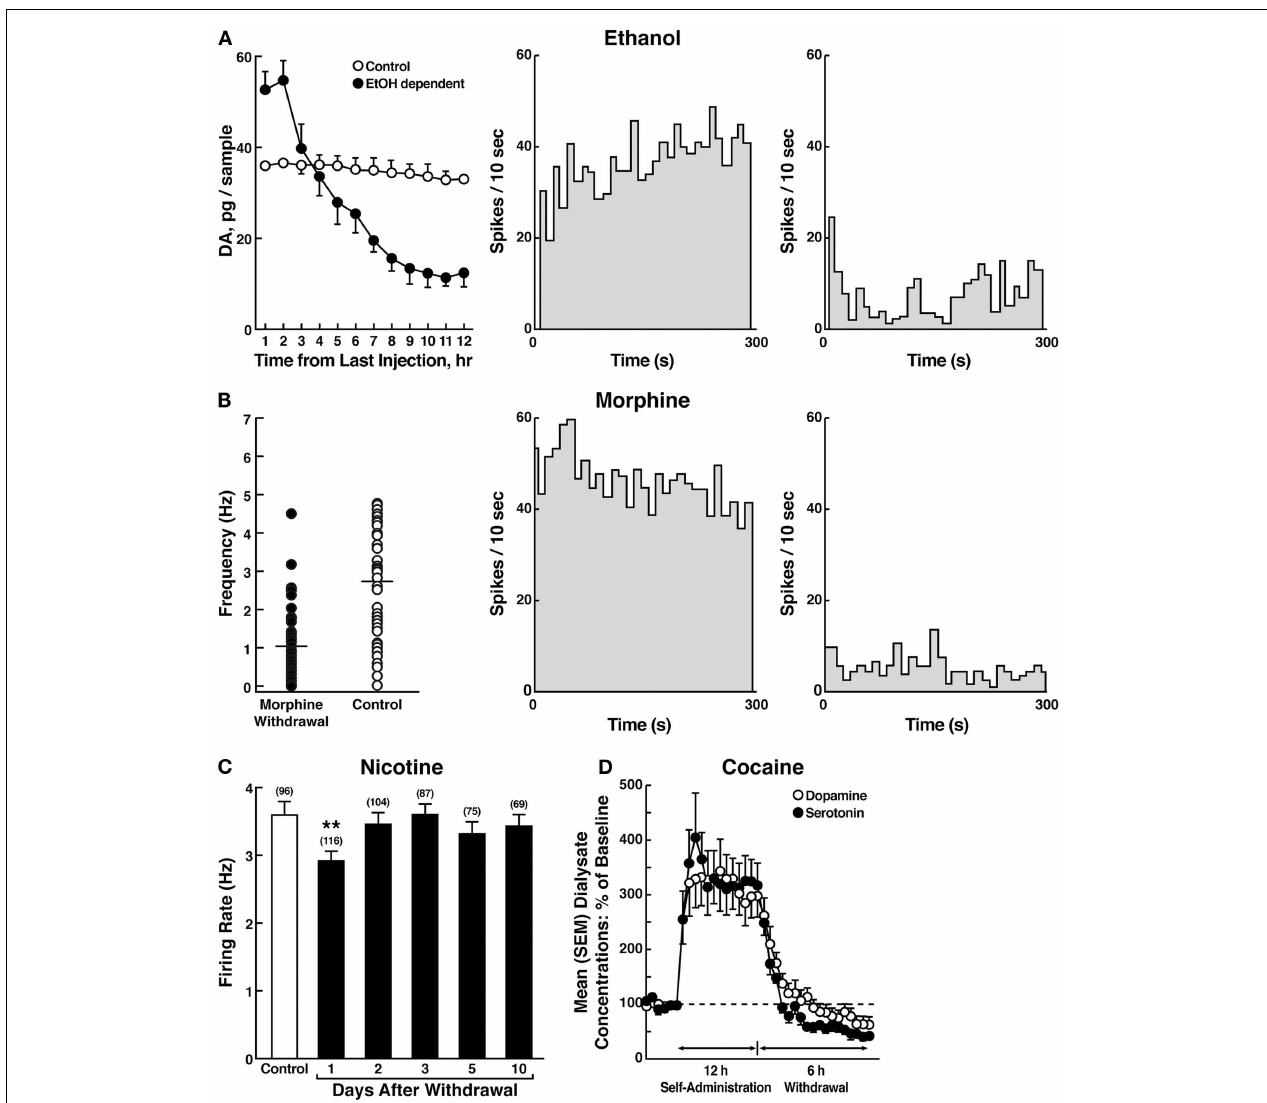
morphine-withdrawn ( right ) rats. Each panel represents the neuronal activity of a single cell. Recordings in both cases were obtained 24h after the last morphine and saline administration, respectively [taken with permission from Ref. (103)]. (C) Firing rates of dopamine cells in the ventral tegmental area following 1–10days of withdrawal from chronic nicotine treatment (6mg/kg/day for 12days).The data are expressed as mean ± SEM.The number of dopamine cells recorded is given in parentheses. * p < 0.01, compared with control group [taken with permission from Ref. (189)]. (D) Profile of dialysate serotonin and dopamine concentrations during a 12-h extended-access